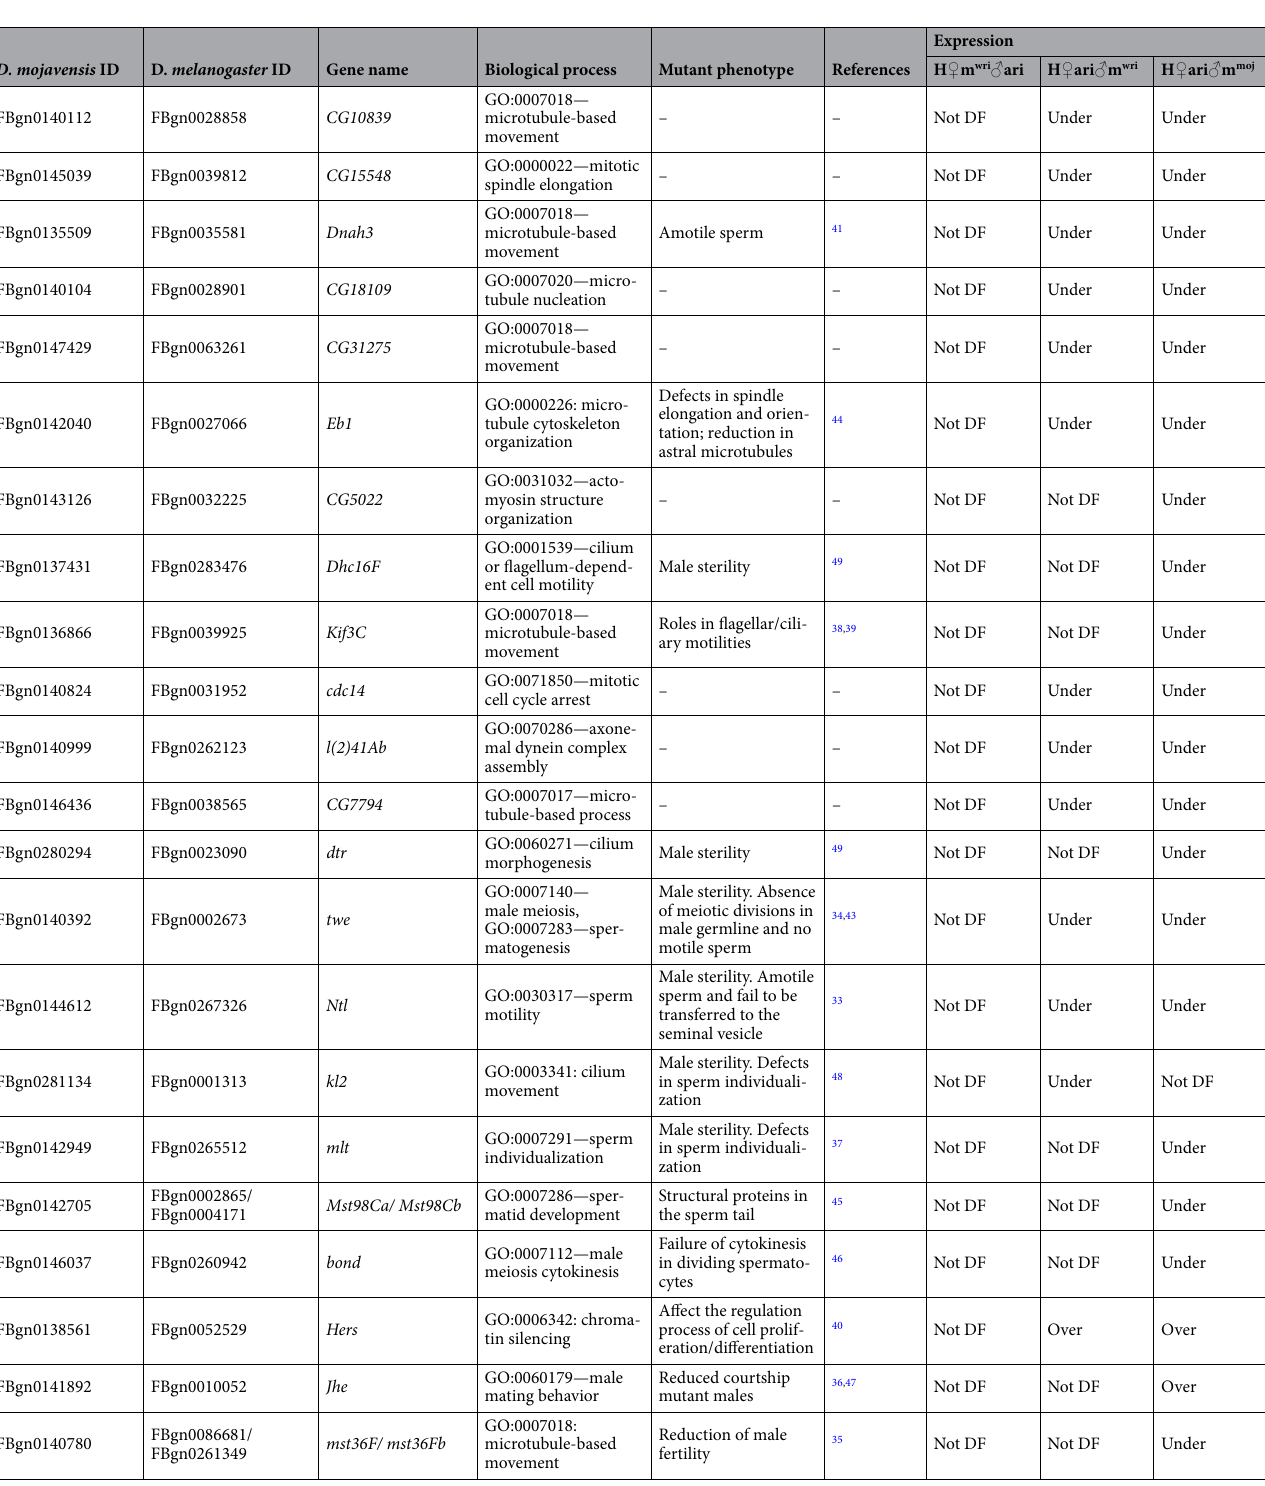
Table 1. DEG in male hybrids gonads with reproductive functions. Deregulated genes in male hybrid gonads presenting spermatogenesis-related functions and their mutant phenotype in other Drosophila species associated to them. DF, Differentially expressed; Under, Underexpressed; Over,